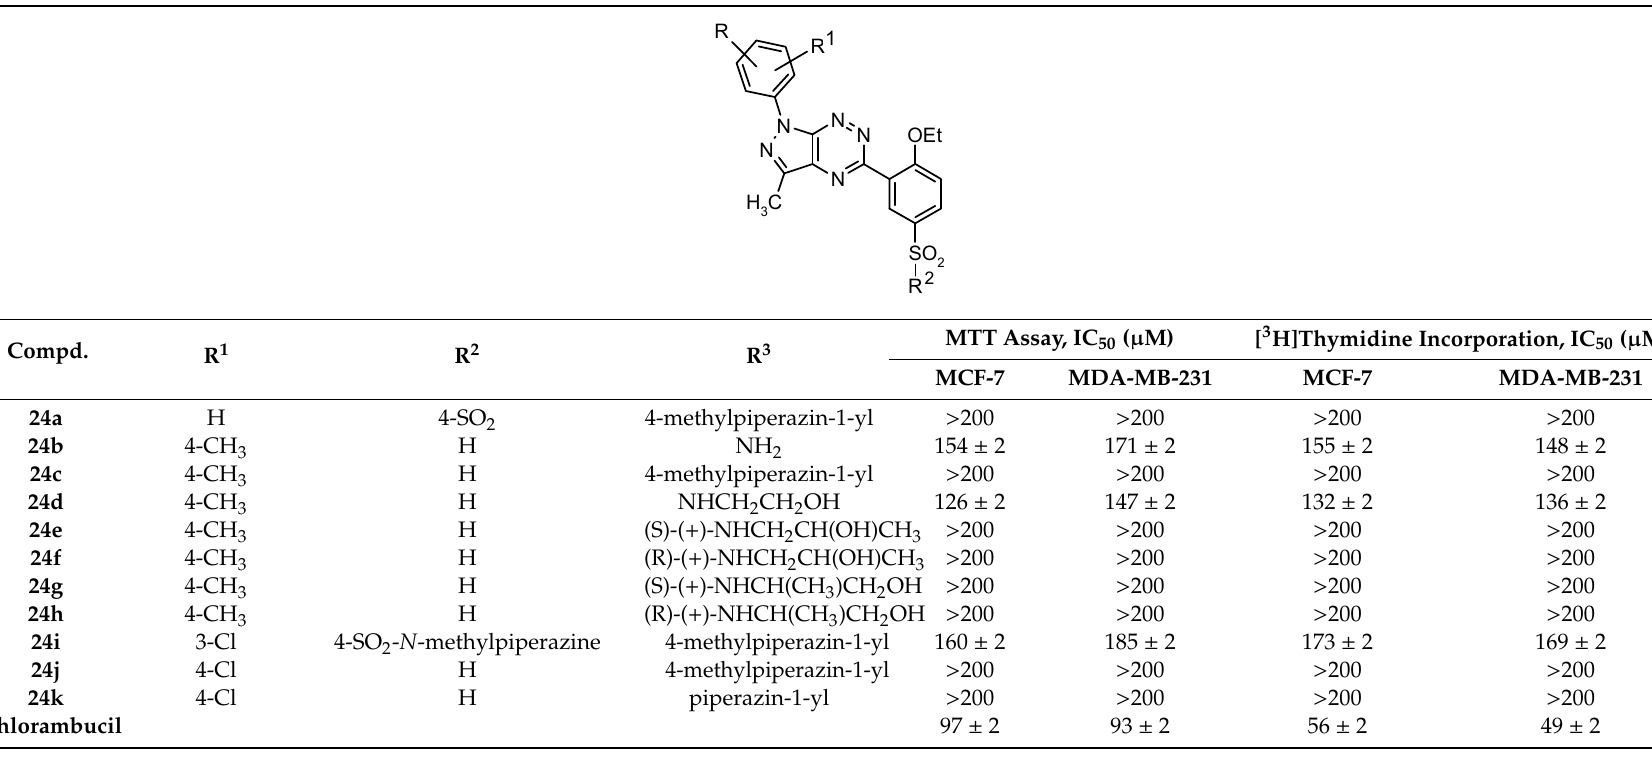
Table 8. Cytotoxic and cytostatic activities of new sulfonamides derivatives of pyrazolo[4,3- e ][1,2,4]triazines 24a–k.